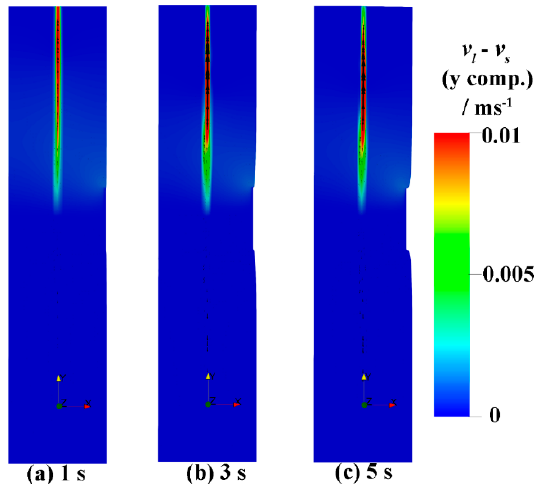
Figure 8. The relative velocity, v l – v s , at different times after punching starts: ( a ) 1 s, ( b ) 3 s, ( c ) 5 s. The contour indicates the vertical component of the relative velocity, v l – v s .